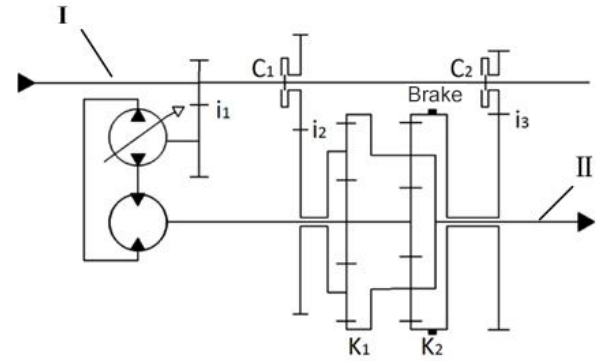
Figure 1. Hydraulic machinery stepless transmission principle dia- gram.